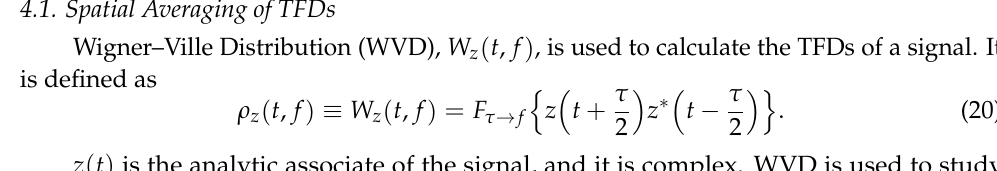
Figure 4. Illustration of the ADTFD algorithm with the DOA estimation